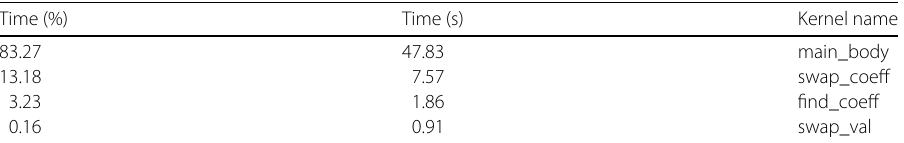
Table 10 Performance of the main kernels for Example 4 Time (%) Time (s) Kernel name 83.27 47.83 main_body 13.18 7.57 swap_coeff 3.23 1.86 find_coeff 0.16 0.91